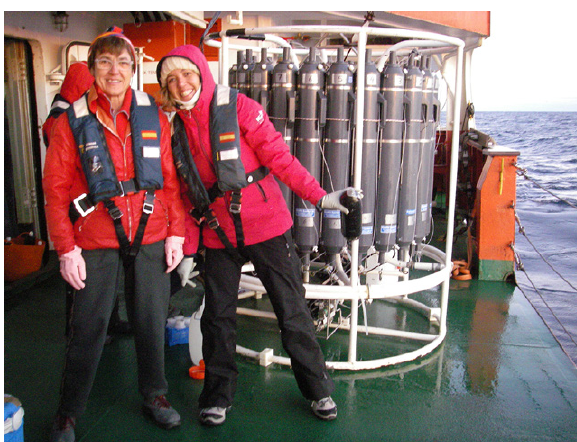
Fig. 1. – Marta Estrada in the Antarctica, with her last PhD student, Sdena Nunes (January 2015).